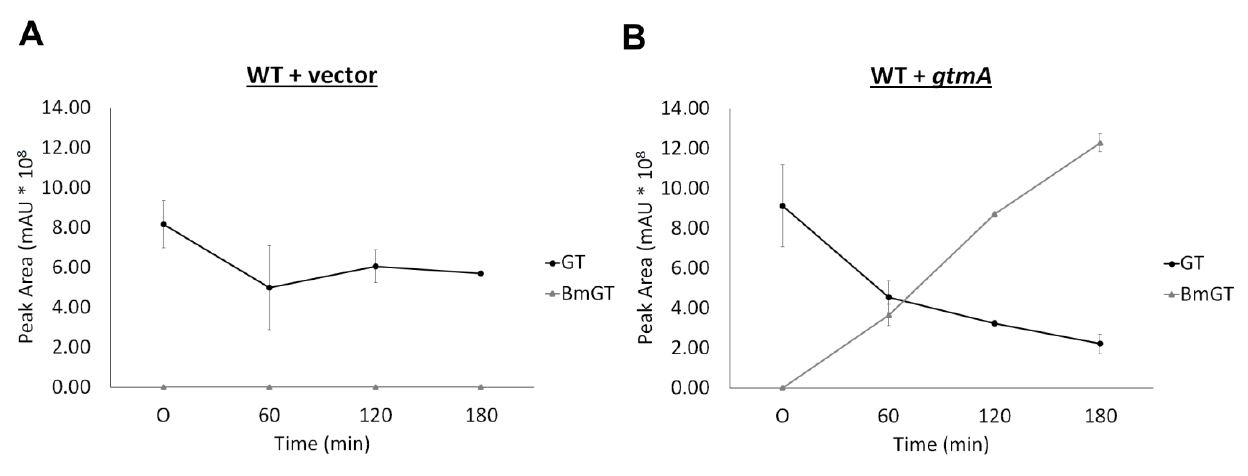
FIGURE 4: Conversion of GT to BmGT over time in yeast expressing GtmA. (A) BmGT is not detected in supernatants of yeast cells exposed to exogenous GT over 3 h exposure. (B) BmGT is readily detected in supernatants from yeast cells expressing gtmA . Increased levels of BmGT can be detected over a 3-hour time period and correlate with a diminution GT